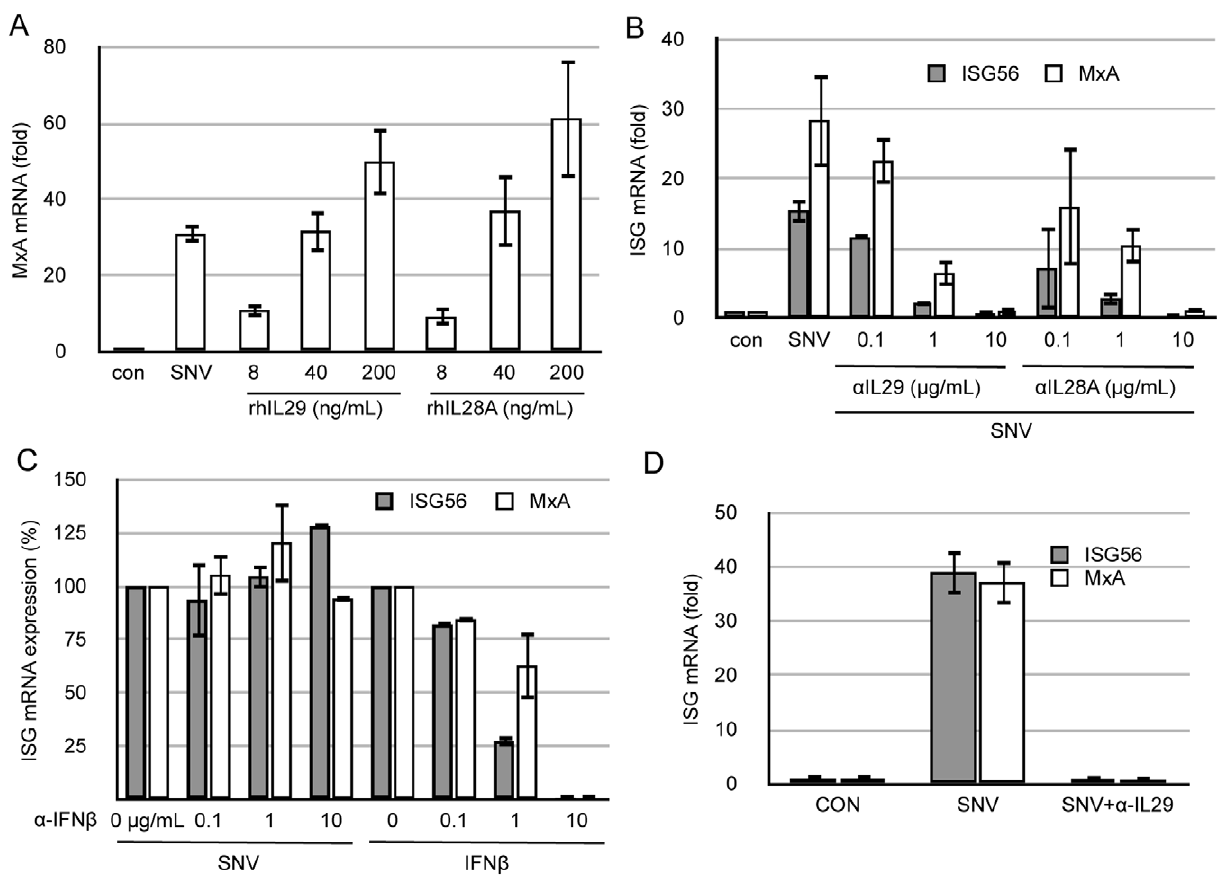
Figure 4. Innate responses to SNV in Huh7 and A549 are specifically due to Vero E6-derived IFN l . Total cellular RNA was isolated from Huh7 or A549 cells and used for ISG quantitation by qRT-PCR. (A) Huh7 were treated with SNV (50 m L of virus) or the indicated amount of recombinant human IL29 or IL28A for 3 h prior to MxA mRNA quantitation by qRT-PCR. (B) Huh7 were infected with SNV at an MOI=1 (50 m L) with or without prior incubation with anti-IL29 or anti-IL28A antibodies at the indicated final concentrations for 1 h. Three hours post infection, ISG56 and MxA mRNA expression was measured by qRT-PCR. (C) SNV or IFN b was preincubated with the indicated amount of anti-IFN b antibody for 1 h. Virus or IFN b was then added to Huh7 cells for 3 h and ISG56 and MxA was measured 3 h post exposure by qRT-PCR. (D) A549 were infected with SNV at an MOI=1, with or without prior incubation with anti-IL29 blocking antibodies (10 m g/mL). Three hours post infection ISG56 and MxA levels were measured by qRT-PCR. Real-time qRT-PCR results for all experiments (parts A–D) are reported as the mean 6 SEM from triplicate biological